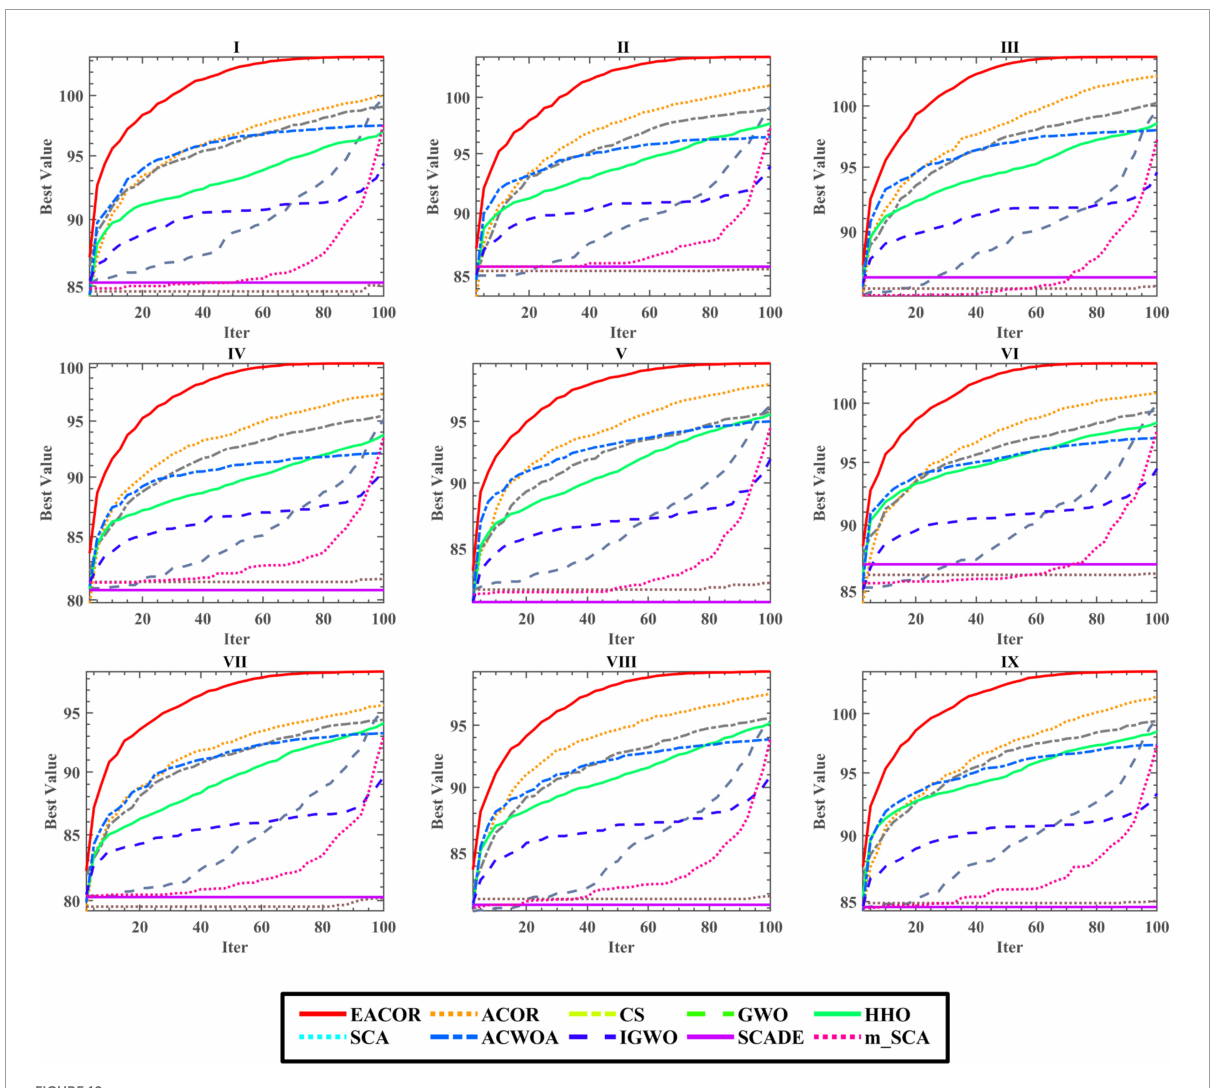
FIGURE19 The convergence curve of 20-level threshold